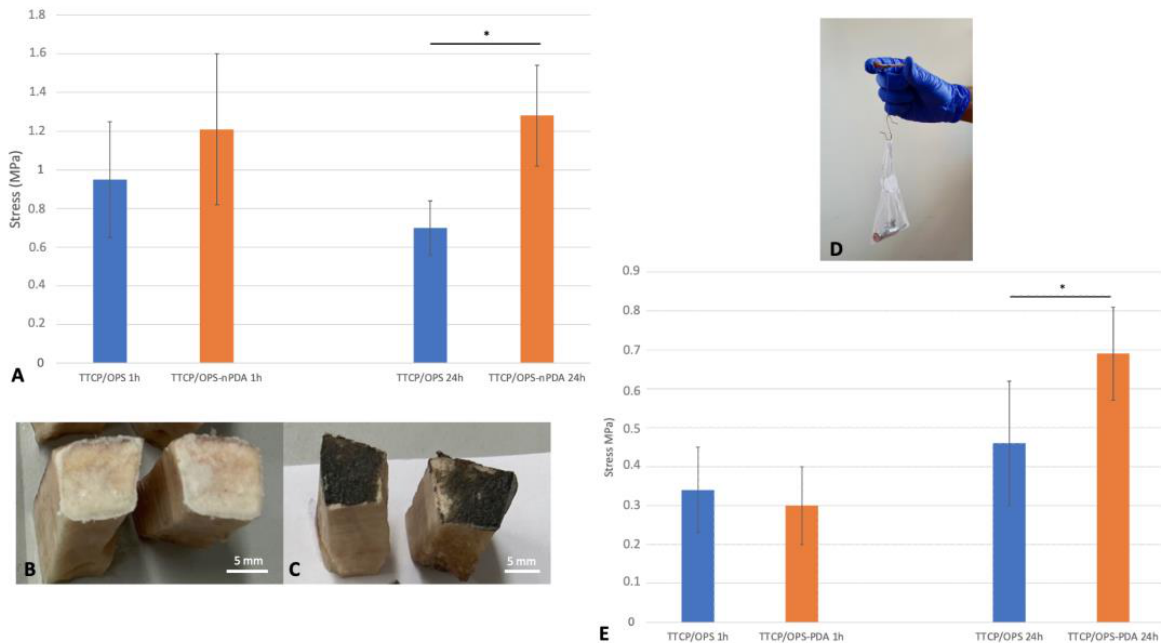
Figure 4. Ex vivo tensile adhesion test comparing TTCP/OPS glue versus TTCP/OPS-nPDA glue after 1 h and 24 h immersions in a 37 °C PBS bath: ( A ) instrumental tensile adhesion test using cuboid bovine cortical bone samples. * stands for a statistically significant difference ( p = 0.00093) between two marked groups; surfaces of bone samples glued with TTCP/OPS; ( B ) with TTCP/OPS- nPDA; ( C ) after rupture, mostly showing a cohesive failure for both; ( D ) experimental setup of man- ual tensile adhesion test on the glued rat tibia/fibula: a fibula segment sample (autograft) was glued to the tibia by a thin layer of the prepared glue, between which a Vicryl ® 4/0 suture thread was deposed perpendicular to the anatomical axis of the tibia and glued together. An evaluation of the adhesive strength was performed by traction with progressively increasing standard weights at- tached to the Vicryl ® thread (minimum N = 7 for each experiment) until rupture of adhesion. The sum of the applied weights was thus noted as the traction force of failure; ( E ) maximum traction